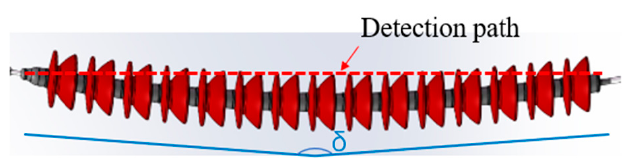
Figure 8. Traditional detection path.